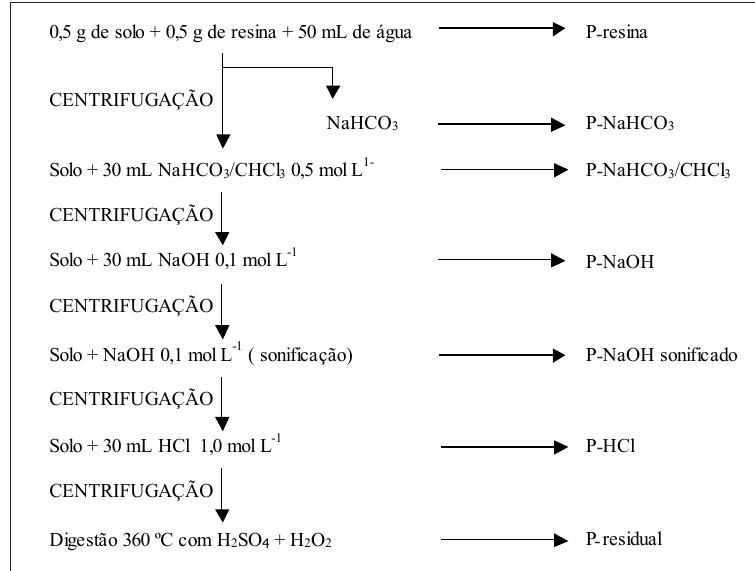
Figura 1. Esquema adaptado do procedimento de extração seqüencial (Hedley et al.,